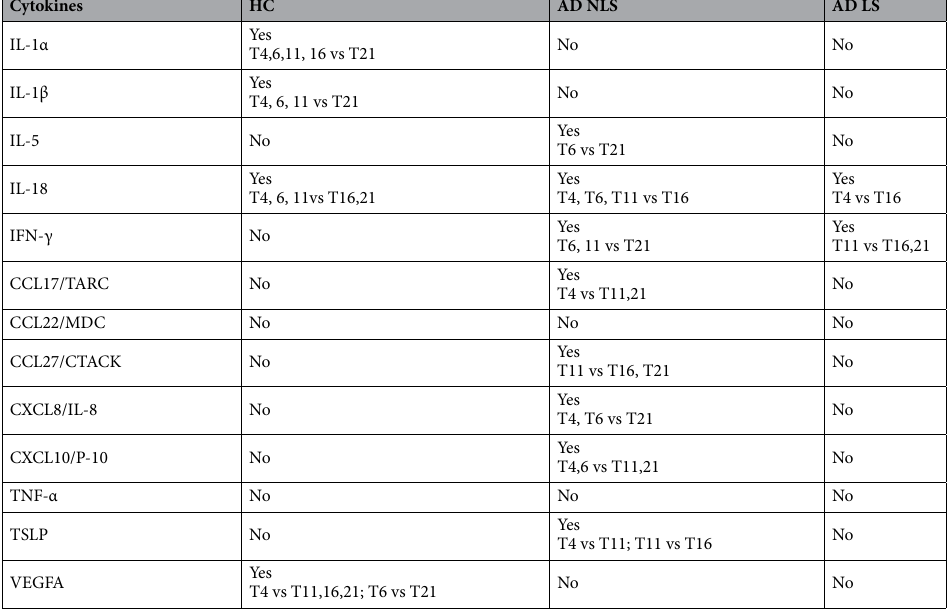
Table 2. Change in cytokine concentration trough depths of stratum corneum. For each column (HC, AD NLS, AD LS) a comparison has been made for each depth towards every other depth, e.g.: T4 vs T4, T4 vs T6, T4 vs T11… T6 vs T11 and so forth. The comparisons with significant findings are written in the table e.g. T4 vs T21. ANOVA multiple comparison for paired data, non-parametric analysis (Friedman’s test) has been performed, with correction for multiple testing controlling false discovery rate (FDR) using original FDR method by Benjamini and Hochberg. Significant findings with corrected p-value < 0.05 are marked as “Yes”. HC healthy controls, AD atopic dermatitis, NLS non-lesional skin, LS lesional skin, T4 Tape 4, T6 Tape 6, T11 Tape 11, T16 Tape 16, T21 Tape 21.